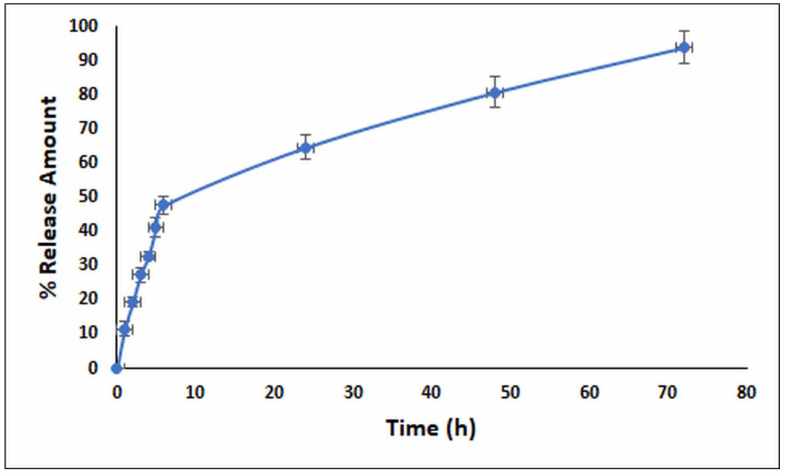
Figure 5. In vitro release profile of the LNEO